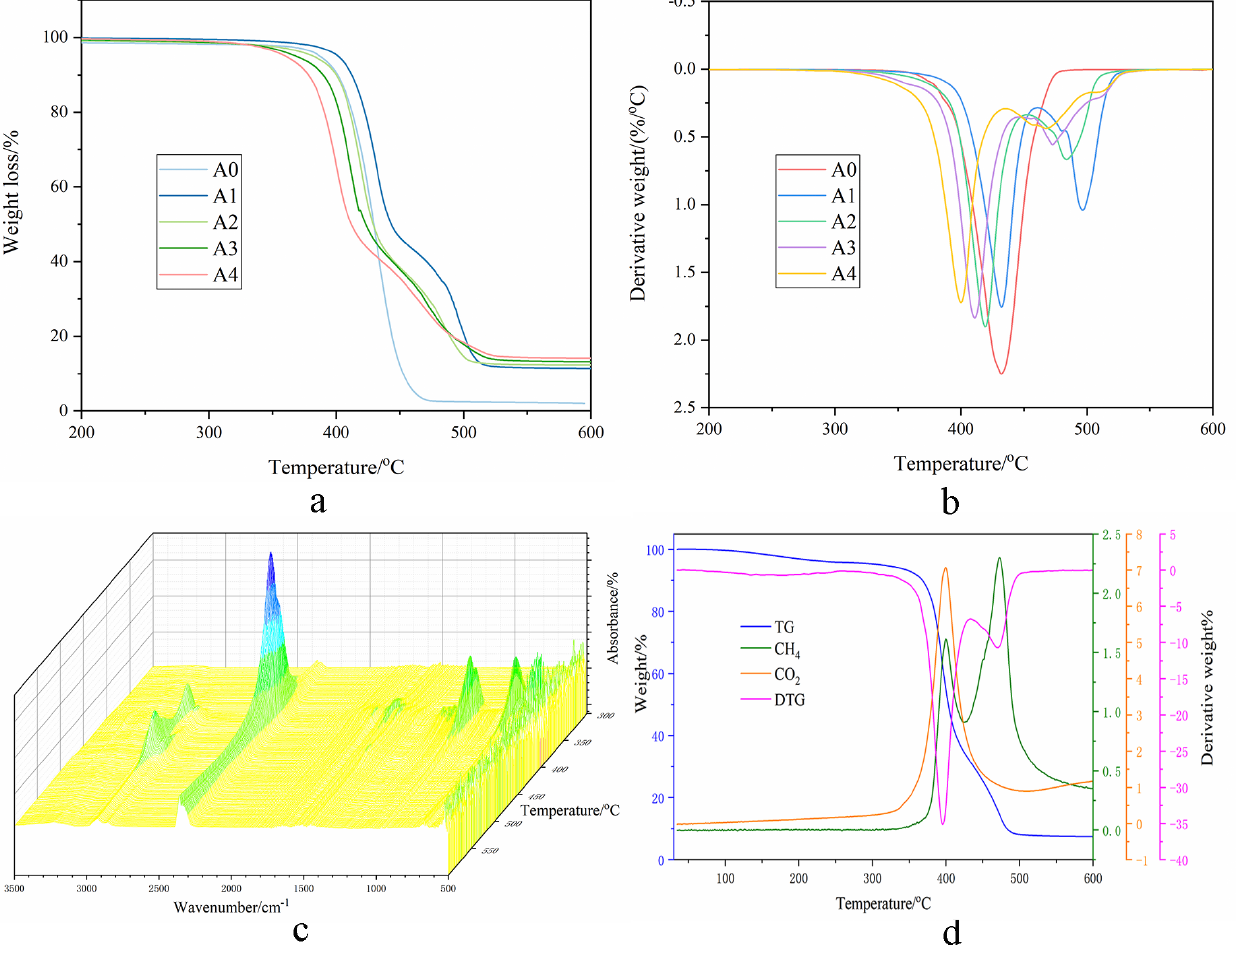
Figure 3. The thermal properties curves of FR–PA66. ( a ) The TGA curves of FR–PA66, ( b ) the DTG curves of FR–PA66, and ( c , d ) the TG–IR curves of FR–PA66.